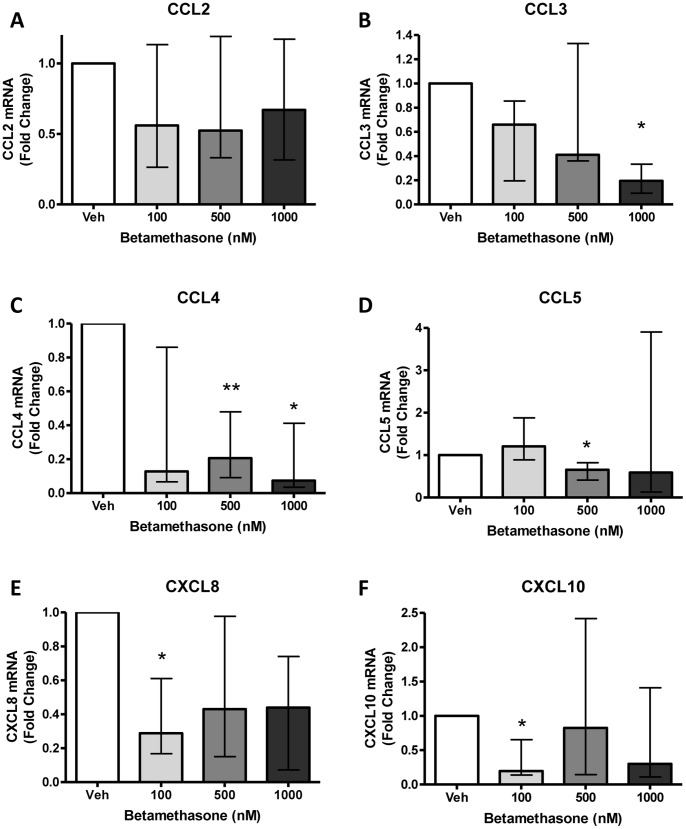
Effect of betamethasone on chemokine mRNA expression by choriodecidual explants.(A) CCL2, (B) CCL3, (C) CCL4, (D) CCL5, (E) CXCL8, (F) CXCL10. Data are fold change from vehicle control, n = 7 per treatment. Data are median and interquartile range, *p<0.05, **p<0.01 compared to vehicle control (Wilcoxon Signed Rank test).